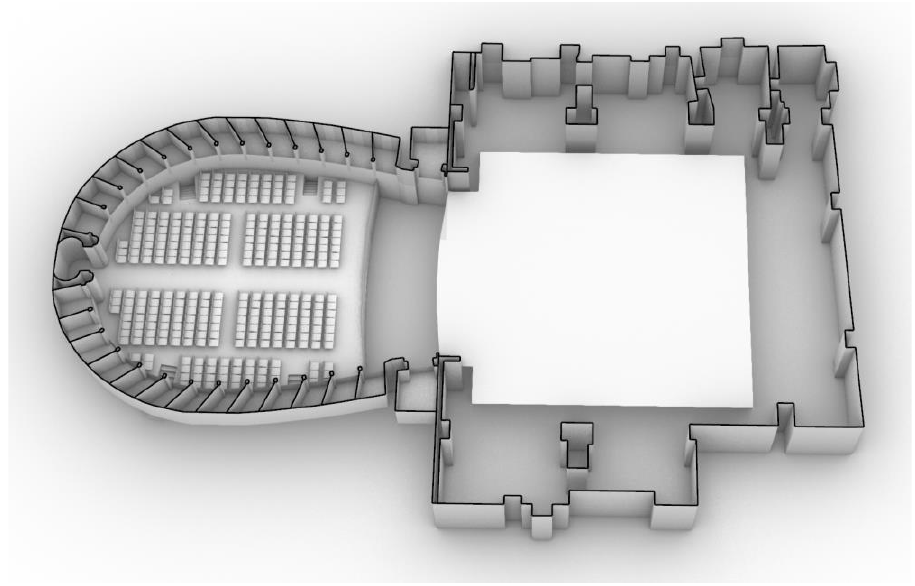
Figure 2. Plan layout of the Ponchielli theater of Cremona.